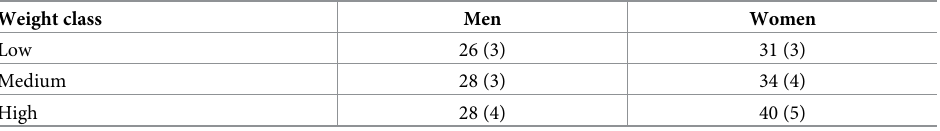
Table 4. Number of barbecuing events per year for the median (and 97.5 th percentile) of the mean extra risk for each subgroup to exceed the median of the mean population